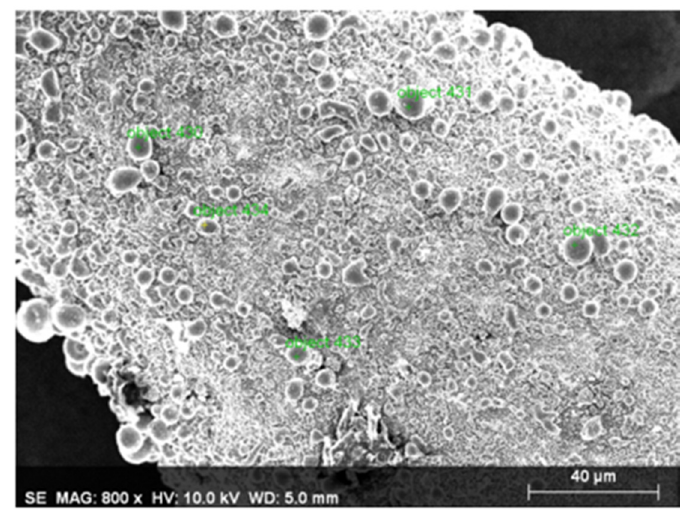
Figure 9. The EDS multi-point sampling area (used electrode).